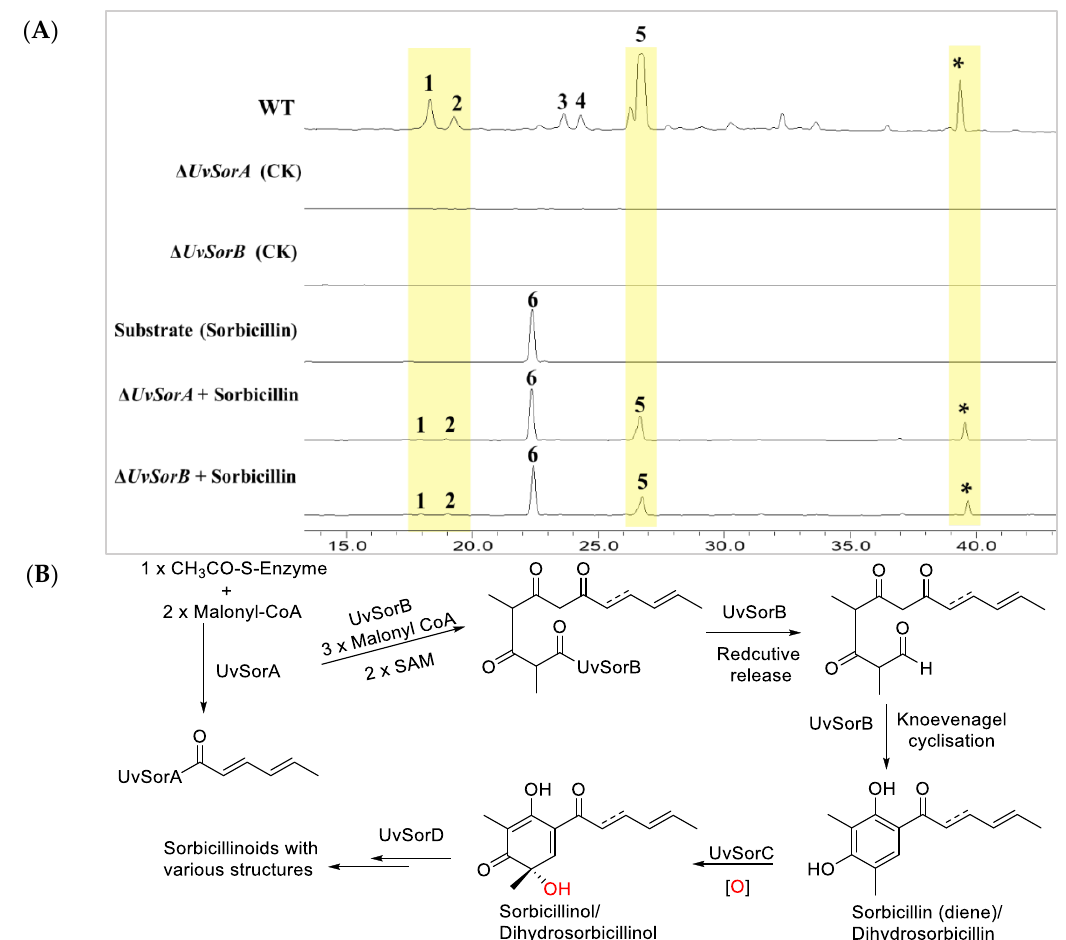
Figure 5. Feeding experiments and proposed sorbicillinol biosynthetic pathway. ( A ) HPLC profiles of WT strain, ∆ UvSorA and ∆ UvSorB mutants, and deletion mutants fed with sorbicillin. The peak marked with an asterisk (*) was presumed as an unidentified sorbicillinoid according to its UV spectrum; ( B ) Summary of the proposed sorbicillinoid biosynthetic pathway in U. virens . Gene deletion, complementation, and precursor feeding experiments provided direct evidence that UvSorA and UvSorB as the structural genes catalyzed the earlier steps of sorbicillinoid biosynthesis, in which acetyl-CoA and malonyl-CoA were cyclized to form